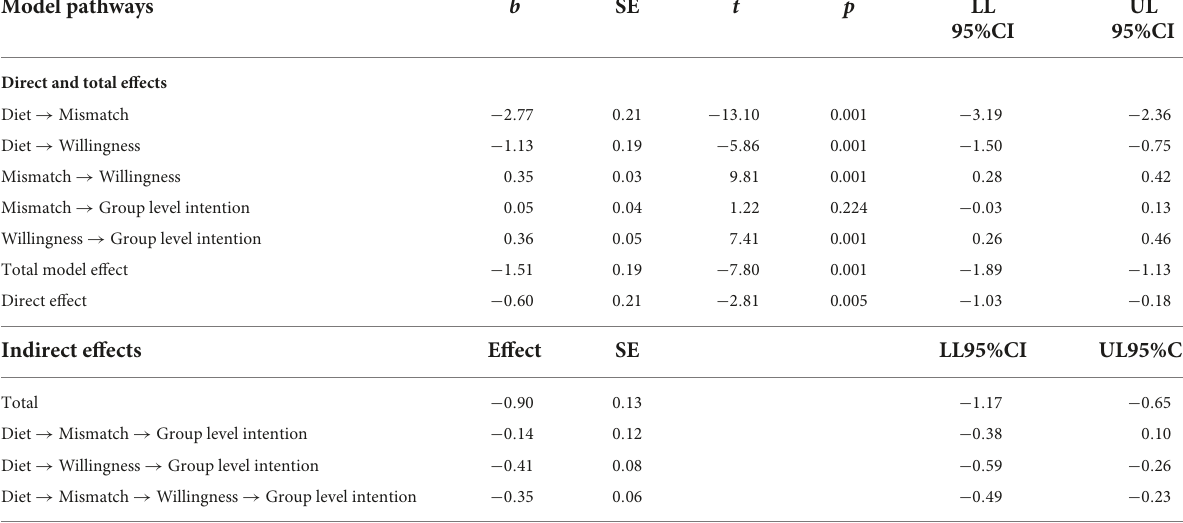
TABLE 2 Direct, indirect, and total effects of the hypothesized model B. Model